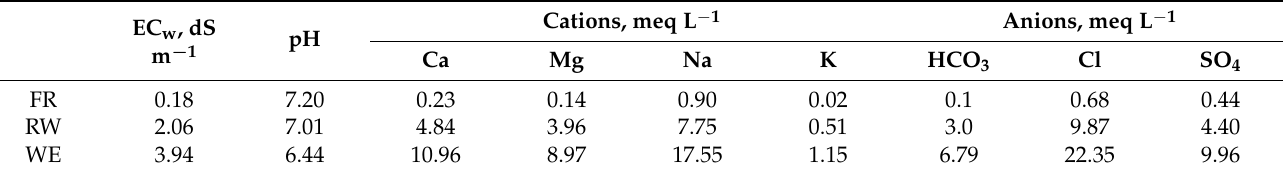
Table 1. Chemical analyses of freshwater (FR), reclaimed wastewater (RW), and well water (WE).